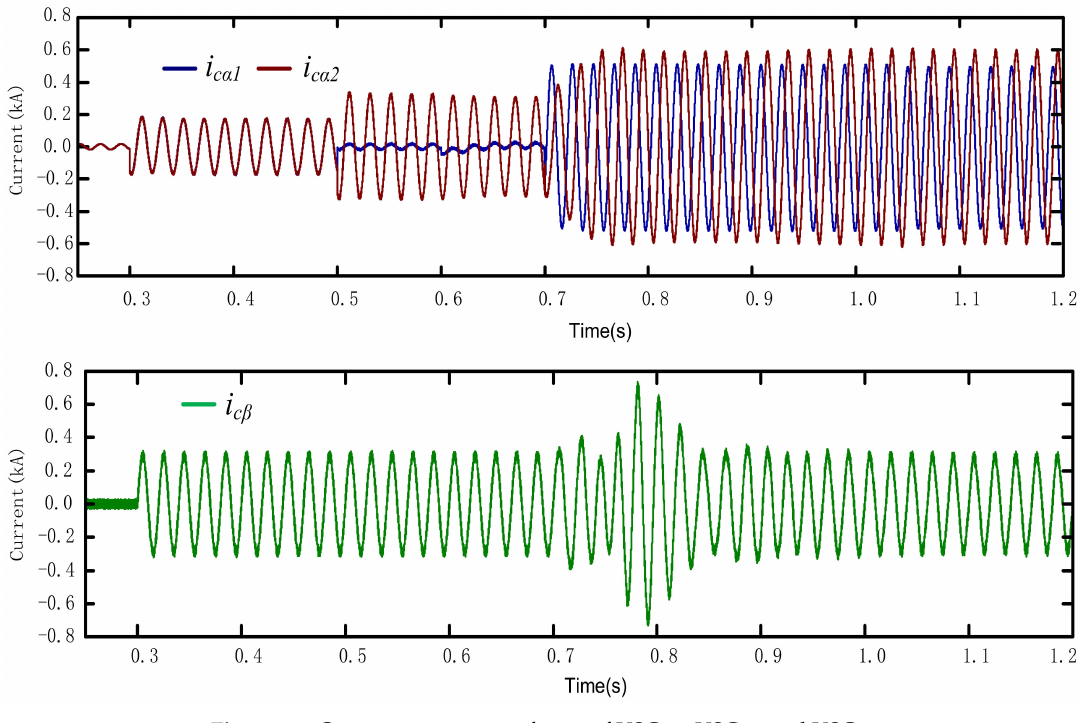
Figure 11. Output current waveforms of VSC α 1 , VSC α 2 and VSC β .